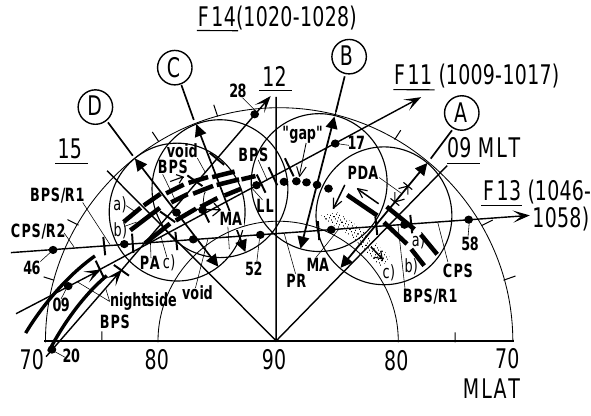
Figure 2 Fig. 2. Schematic illustration of dayside auroral